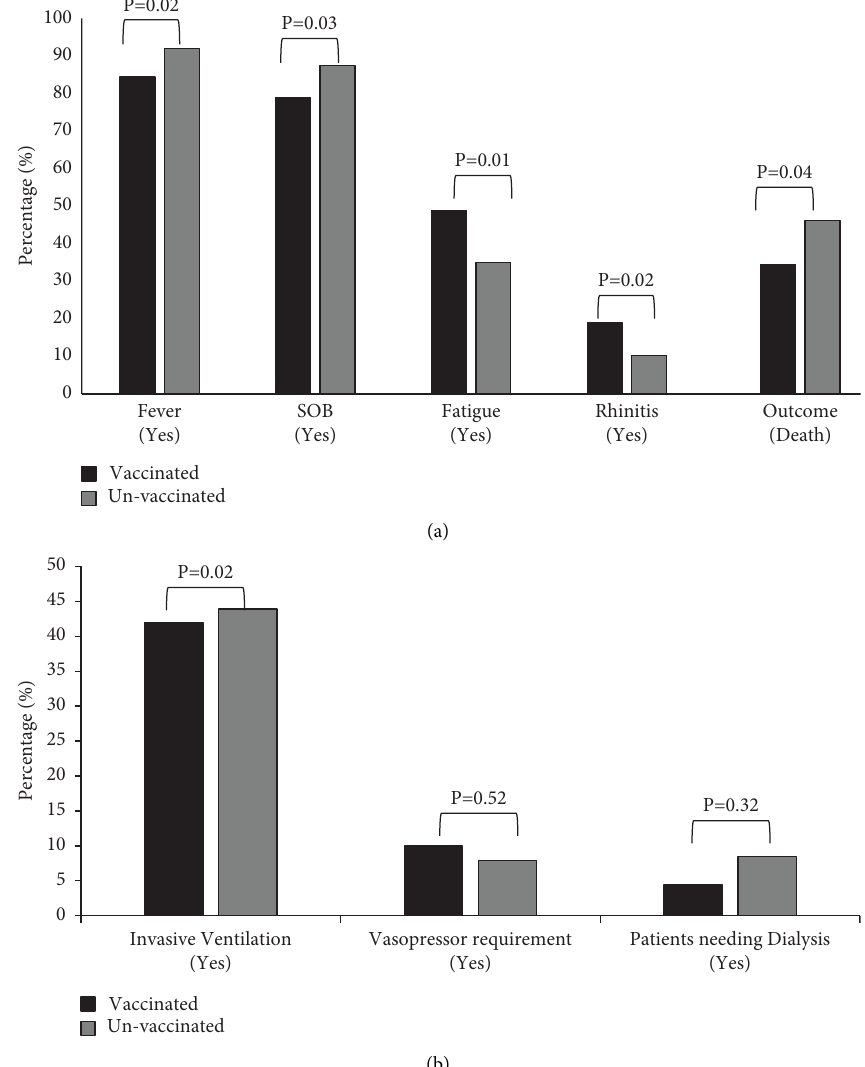
Figure 1: (a and b): depicting the comparison of clinical symptoms and organ support requirement between the vaccinated and the unvaccinated group by student t ’ test. SOB: shortness of (1476.0 ± 226.0 Vs. 1470.0 ± 225.0, P < 0 . 0363) lymphocytes